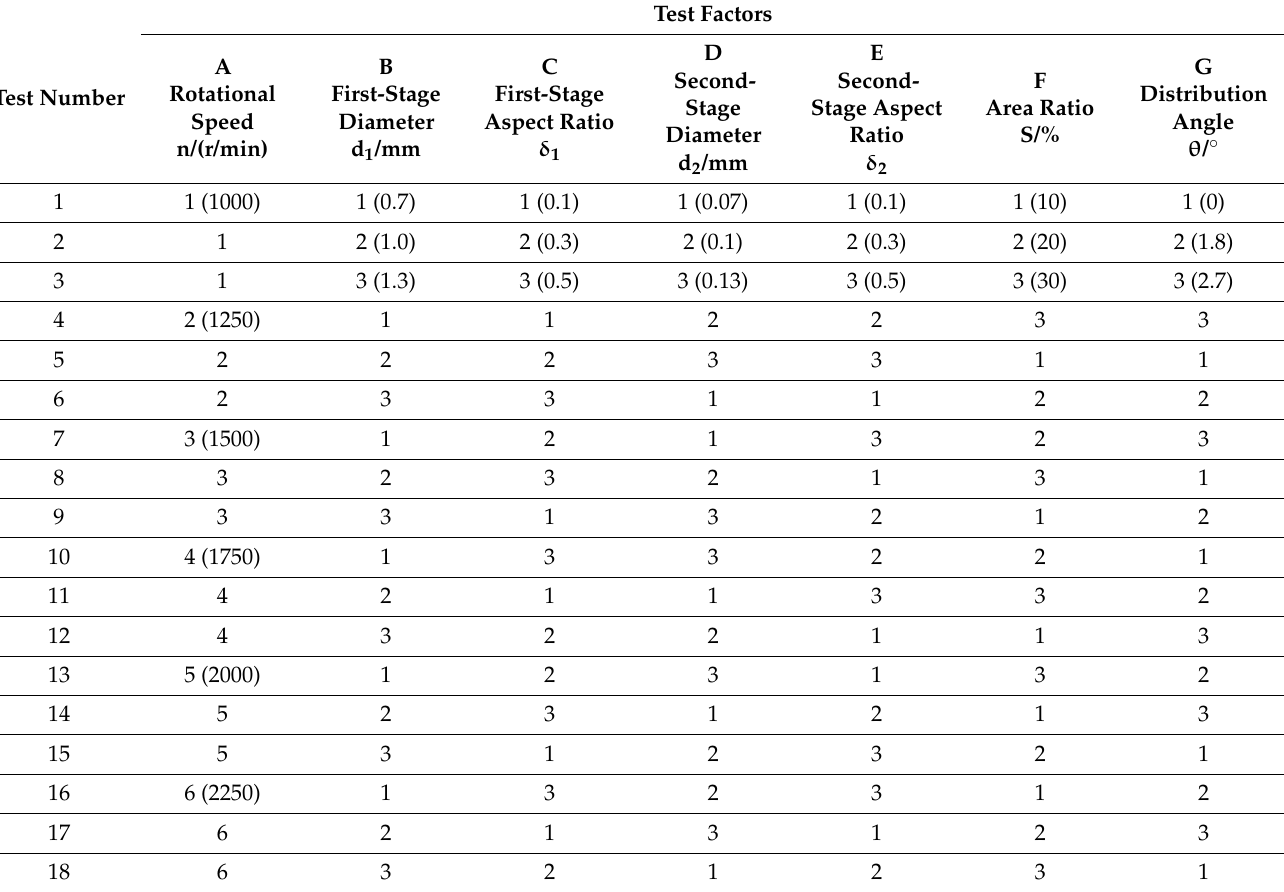
Table 1. Numerical simulation table of L 18 (6 × 3 6 ) orthogonal